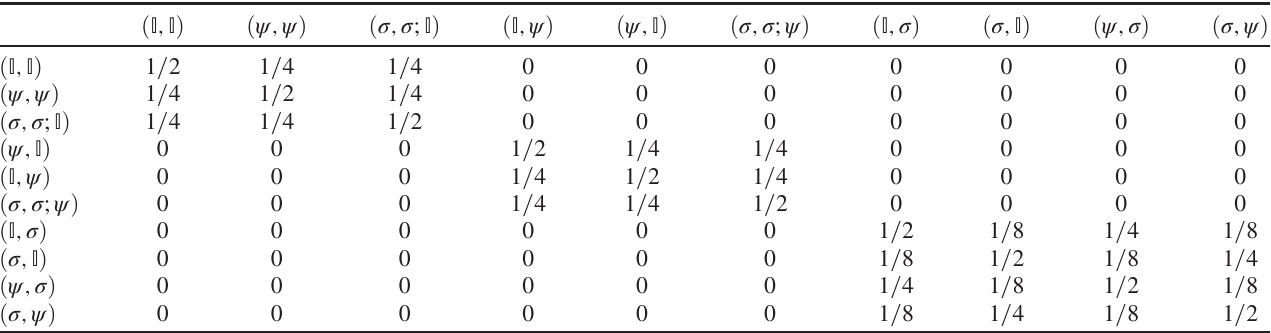
TABLE II. Transition matrix P ð A → B Þ following from Eqs. (3) – (5). The three blocks have topological charge I , ψ , and σ ,